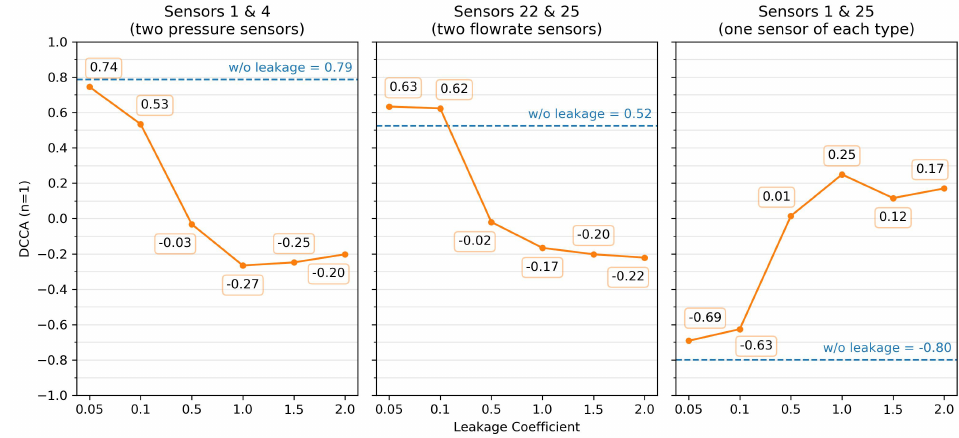
Figure 12. DCCA variation with the leakage coefficient in three selected pairs from chunk 702 using a time window of 40 time points.